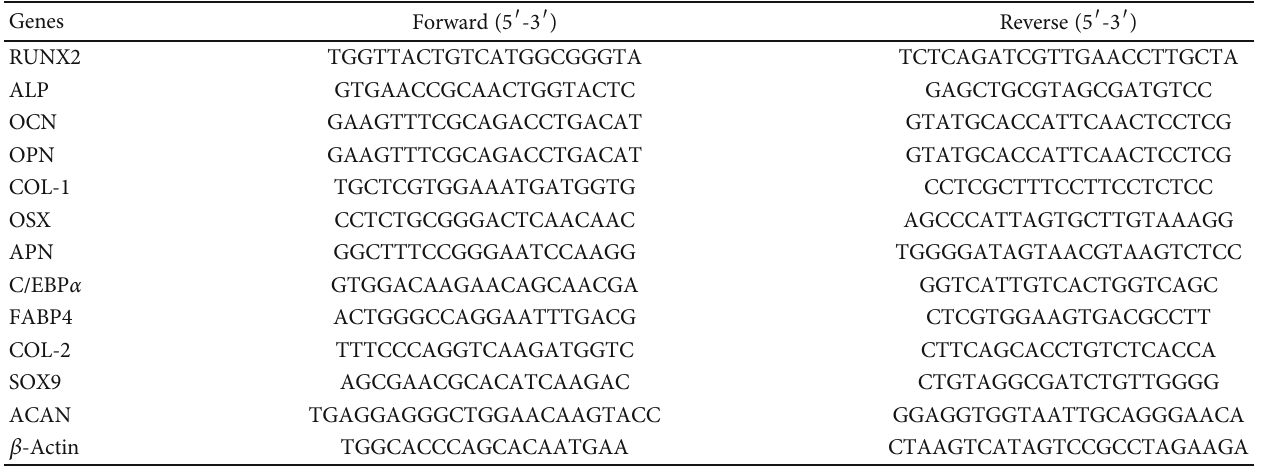
Table 1: All primers used for